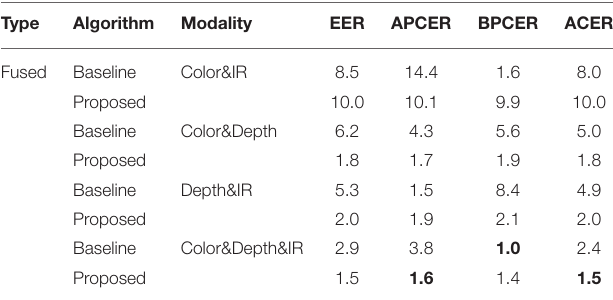
TABLE 4 | Error rates (%) of the proposed and baseline algorithms on the CASIA-SURF database (Zhang et al.,